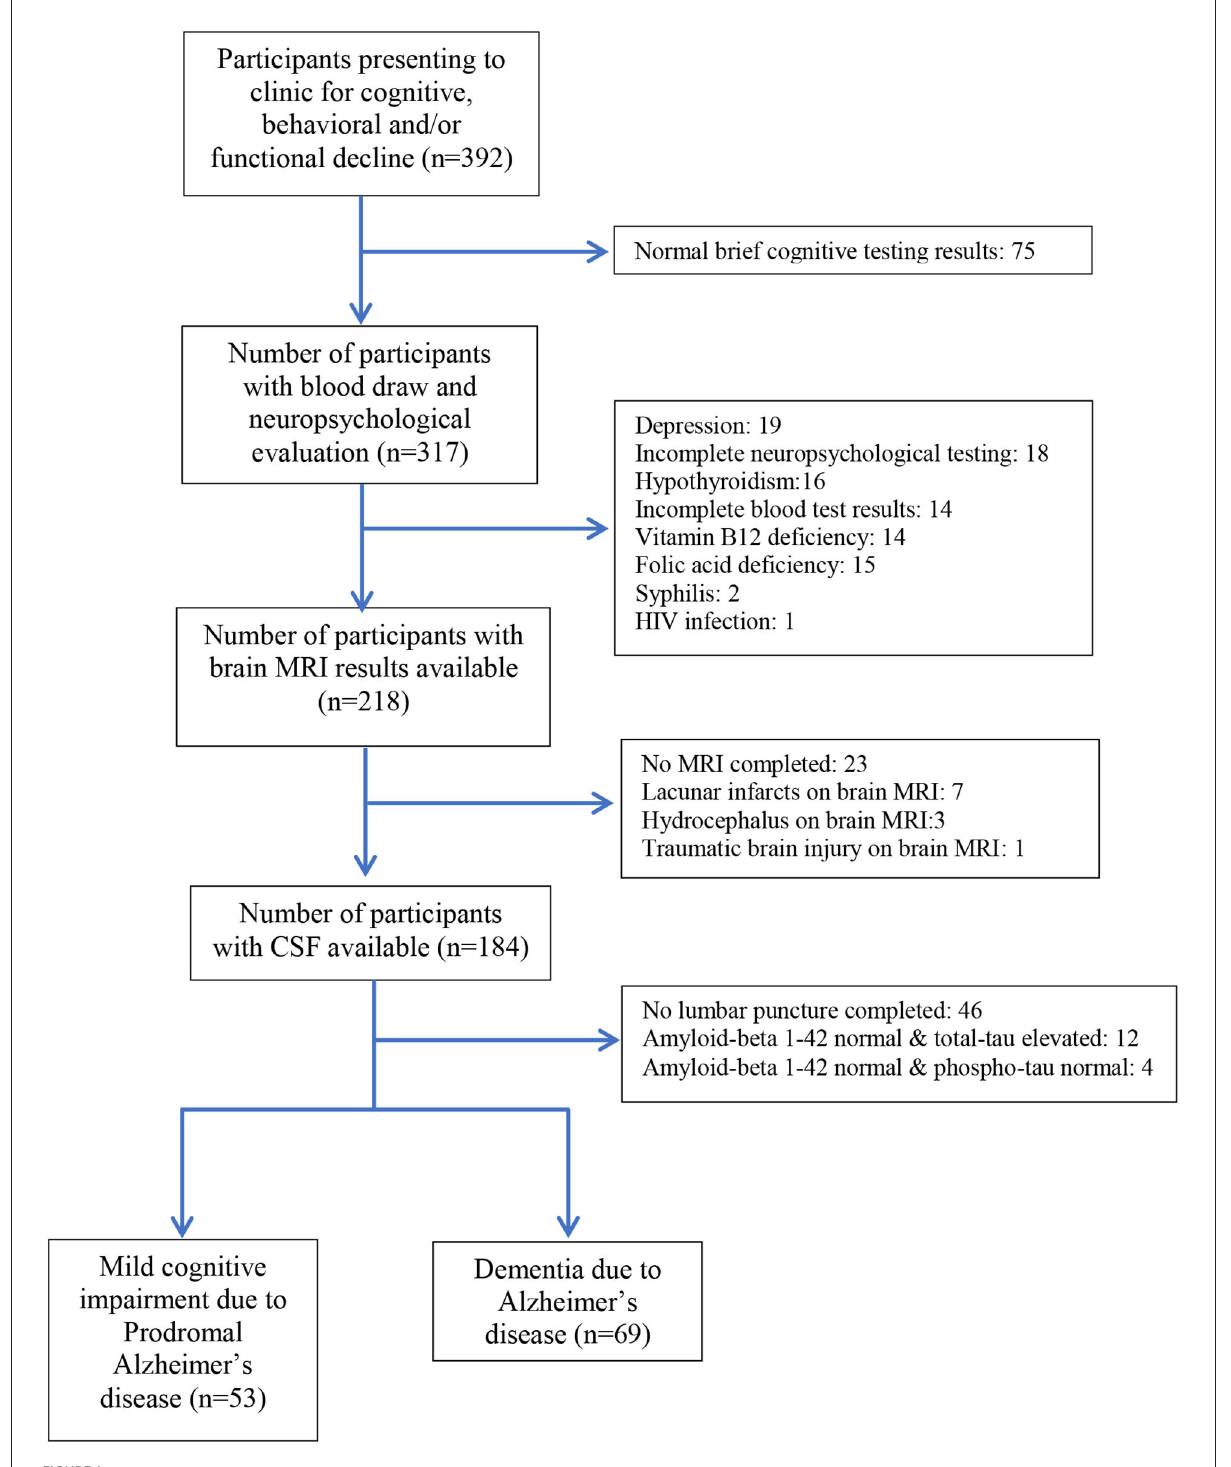
FIGURE1 Participant selection flowchart for patients with Alzheimer’s disease and prodromal Alzheimer’s